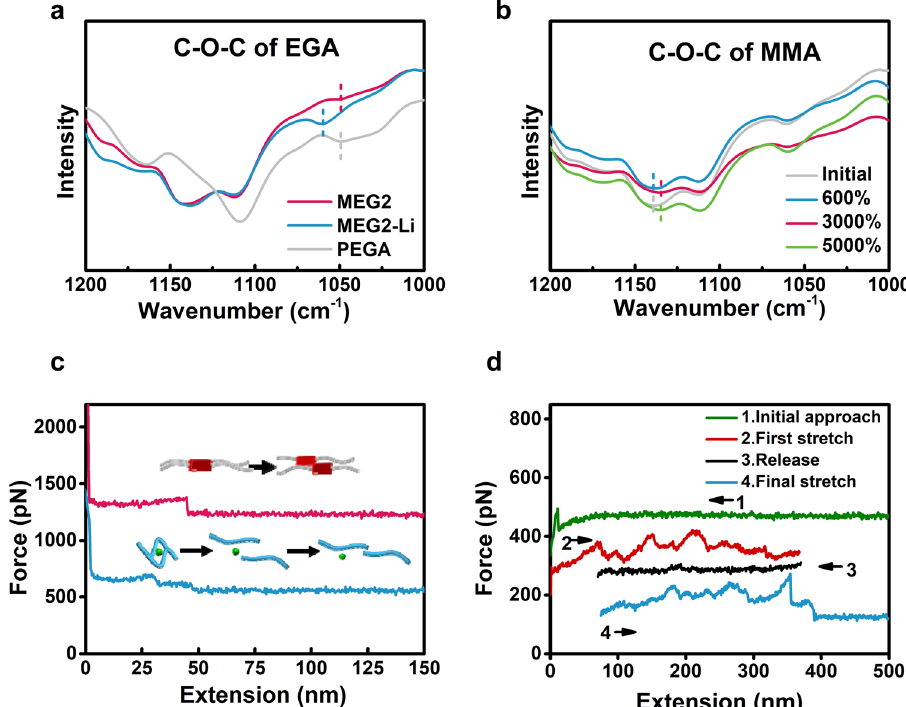
Fig. 5 Mechanism. a FTIR spectrum of PEGA, MEG2, MEG2-Li. b The vibration changes of C-O-C on MMA side chains under stretching. c Typical force-